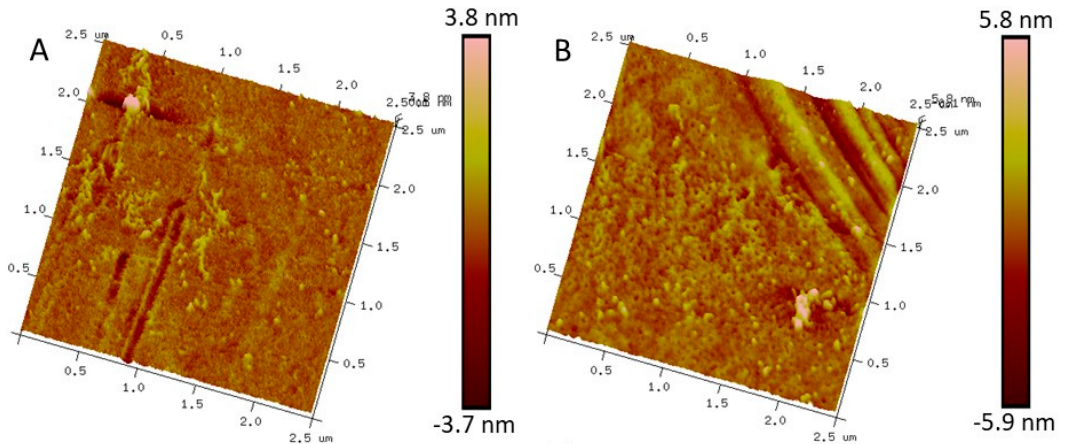
Figure 1. Atomic Force Microscopy image (2.5 × 2.5 μ m 2 ) of A β 1-42 after 48 h of incubation were obtained using ScanAsyst mode (Bruker, USA). ( A ) Isolated fibers of A β 1-42 can be seen. ( B ) A quasi-uniform layer of A β 1-42 fibers can be observed.